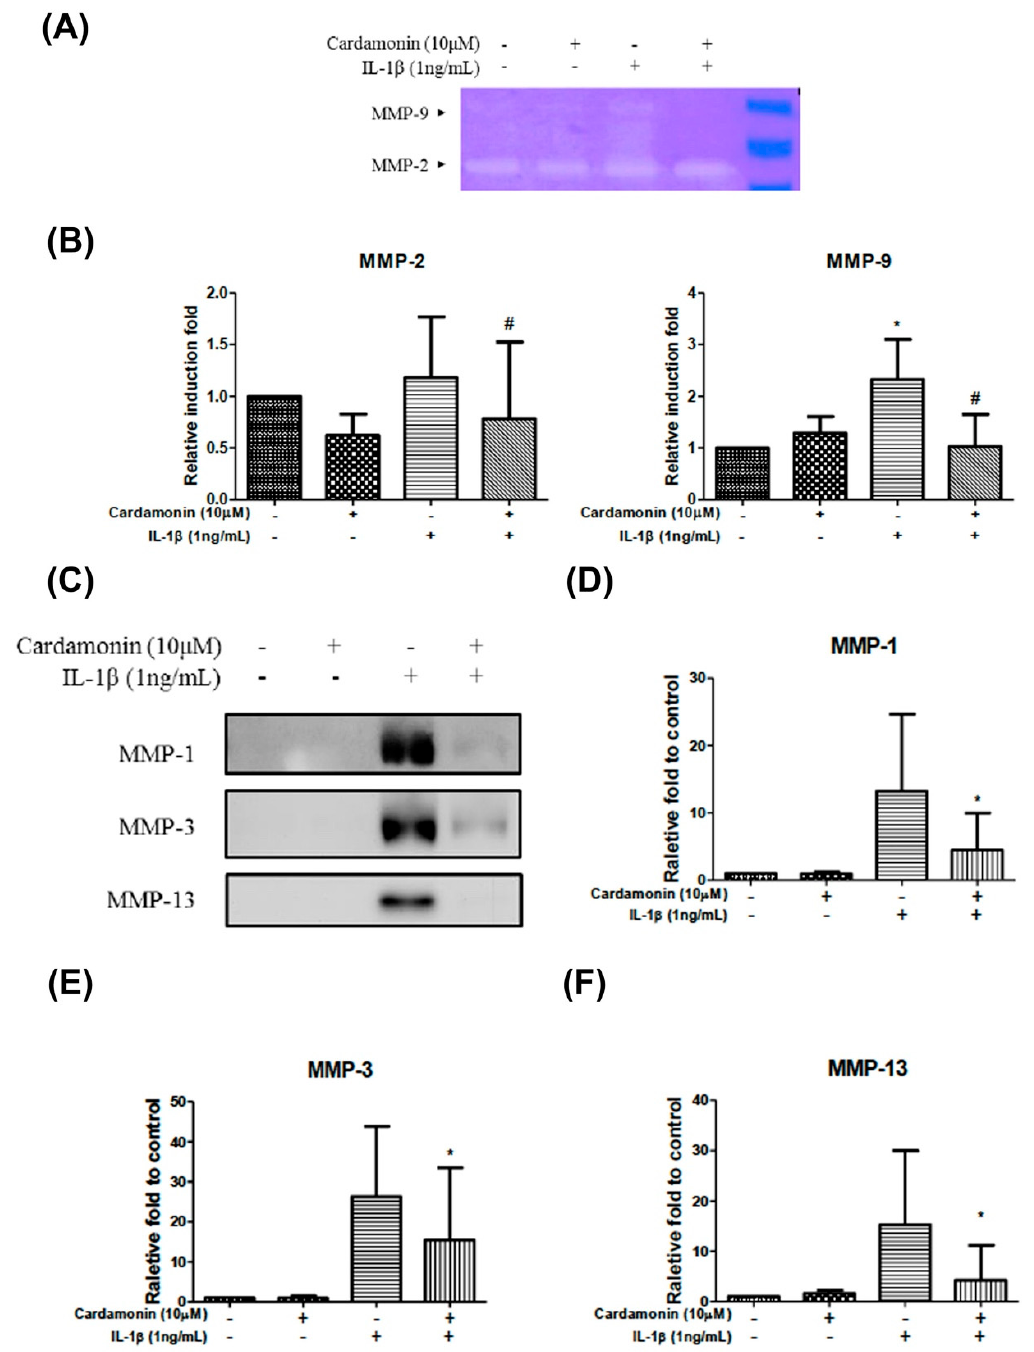
Figure 2. Cardamonin suppressed the activities of MMP-2 and MMP-9 as well as the protein expression levels of MMP-1, MMP-3 and MMP-13 in human OA chondrocytes induced by IL-1 β . ( A , B ) Gel images revealed the analysis of cardamonin effects on MMP-2 and MMP-9 activities of IL-1 β insulted using gelatin zymography gel. ( C – F ) Protein expression levels of MMP-1, MMP-3 and MMP-13 in IL-1 β -induced chondrocytes following treatment with 10 µ M cardamonin for 24 h. MMP-1, MMP-3 and MMP-13 protein expression demonstrate the analysis of cardamonin effects with IL-1 β treatment, and significantly reduced with cardamonin. All data comes from at least three independent experiments, and their significance were as follows: cardamonin group and the control group are indicated by an asterisk (*); cardamonin group and the IL-1 β group are indicated by a hash symbol (#). *, # p <